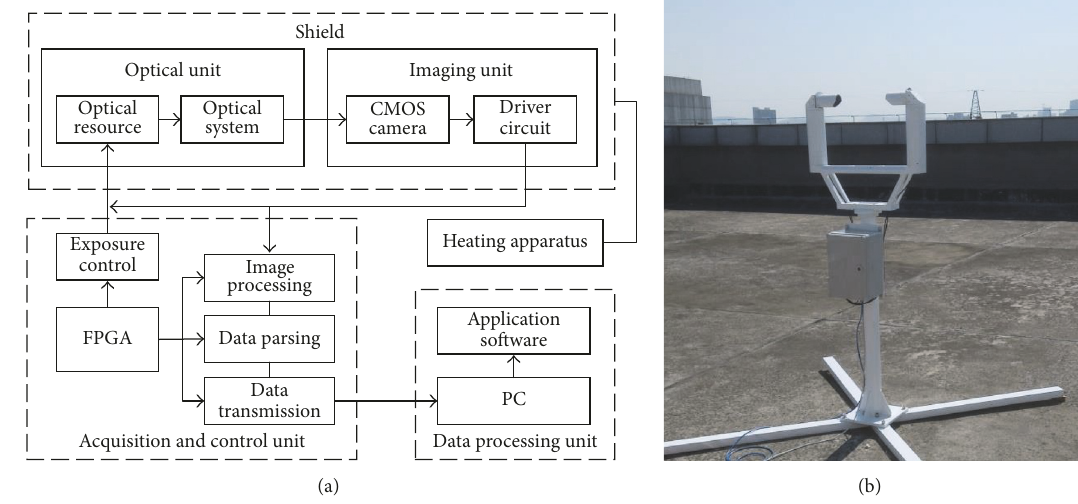
Figure 1: The framework and a photograph of the